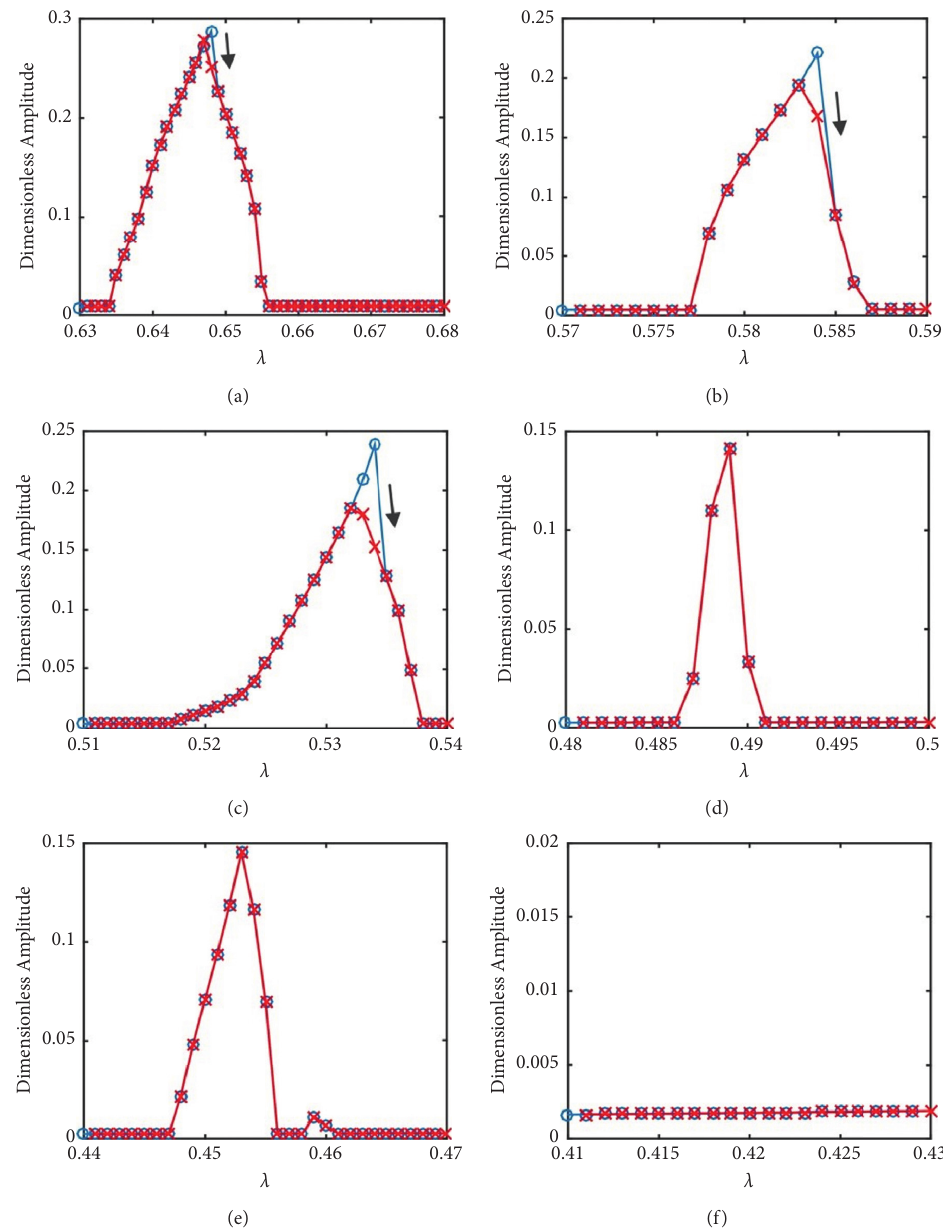
Figure 7: The amplitude-frequency curves in VC frequency resonance region, where ° indicates run-up and × indicates